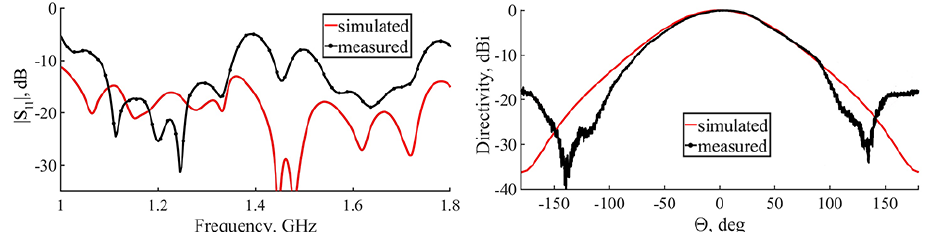
Fig. 8. Simulated and measured input reflection coefficient of the proposed antenna.